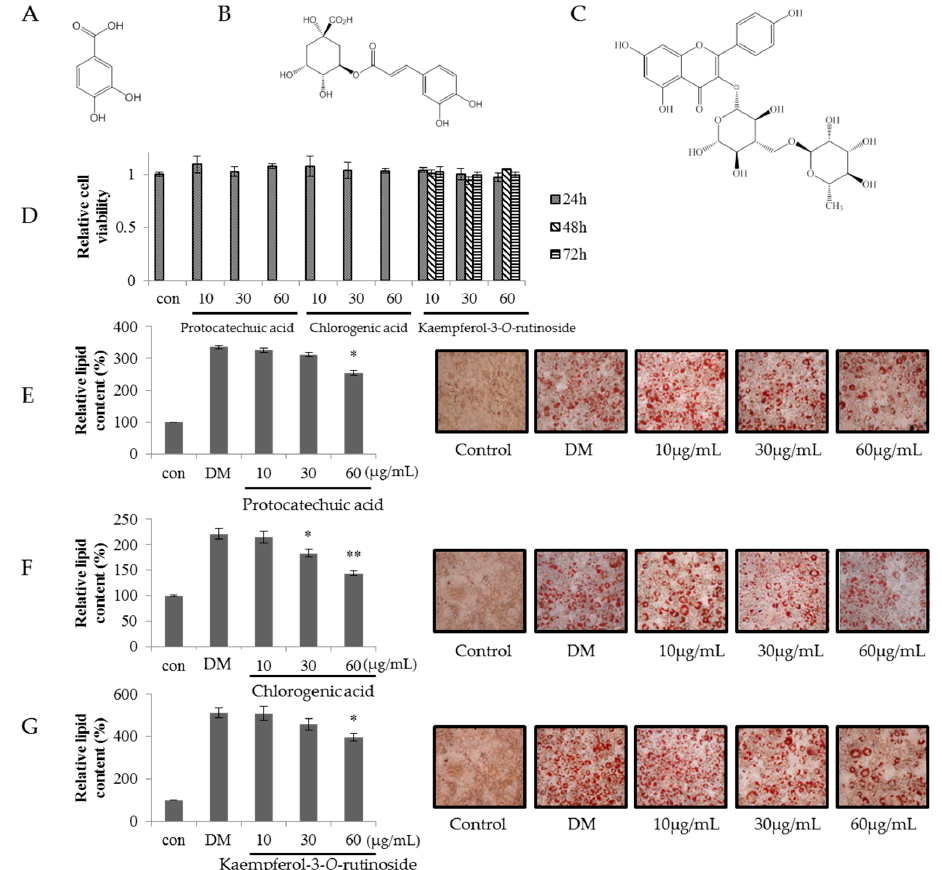
Figure 5. Molecular structures of ( A ) protocatechuic acid; ( B ) chlorogenic acid; and ( C ) kaempferol-3- O -rutinoside; ( D ) preadipocyte viability effect of protocatechuic acid, chlorogenic acid and kaempferol-3- O -rutinoside; relative lipid content and Oil Red O staining images of ( E ) protocatechuic acid; ( F ) chlorogenic acid; and ( G ) kaempferol-3- O -rutinoside. Three independent experiments have been carried out; * p < 0.05 vs. DM; ** p < 0.01 vs.